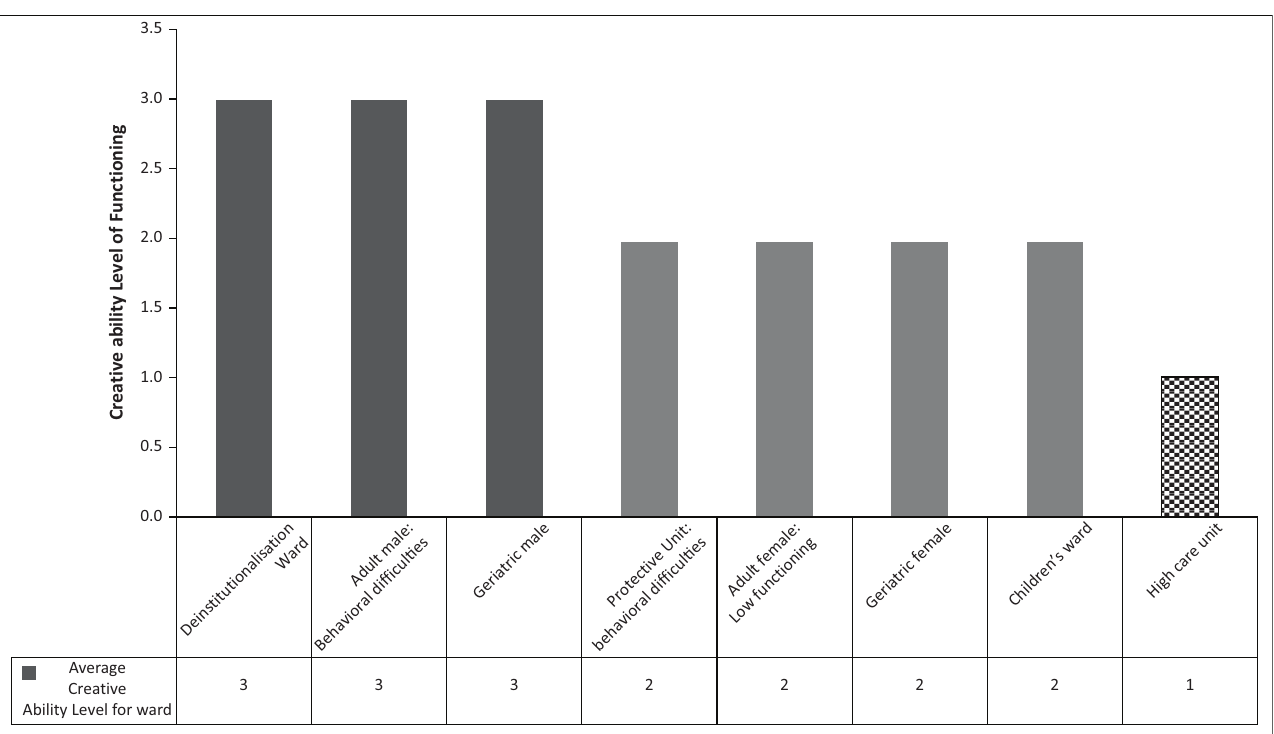
FIGURE 1: Average creative ability level of functioning per